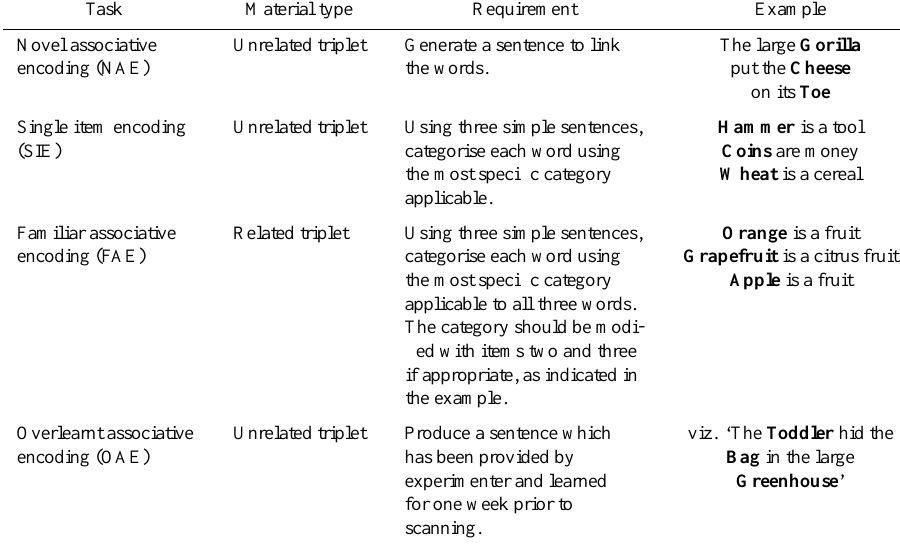
Table 1 Outline of the four verbal encoding tasks that were compared using